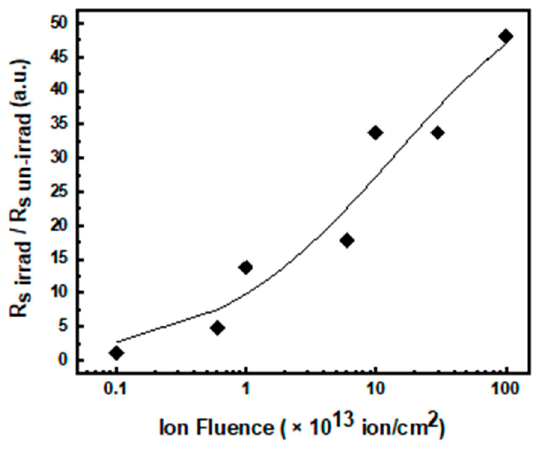
Figure 3. Normalized series resistance as a function of irradiation fluence.